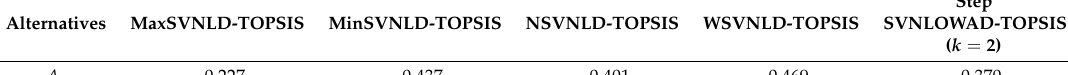
Table 10. Closeness coefficients, C (cid:48) ( A i ) , obtained under particular cases of the SVNLOWAD-TOPSIS approach.